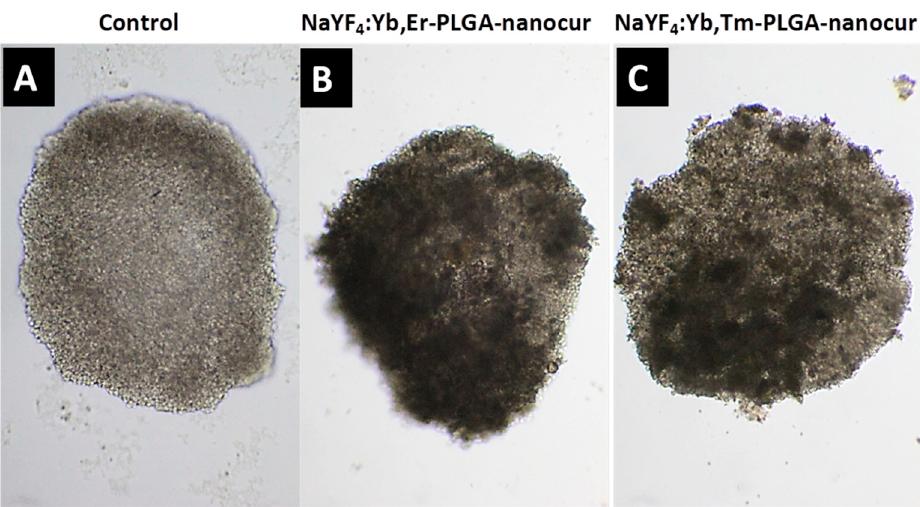
Figure 8. Viability of C6 cells in spheroids after 48 h of incubation with NaYF 4 :Yb,Er-PLGA-nanocur and NaYF 4 :Yb,Tm-PLGA-nanocur. MTS assay, the viability of intact cells was taken as 100%.